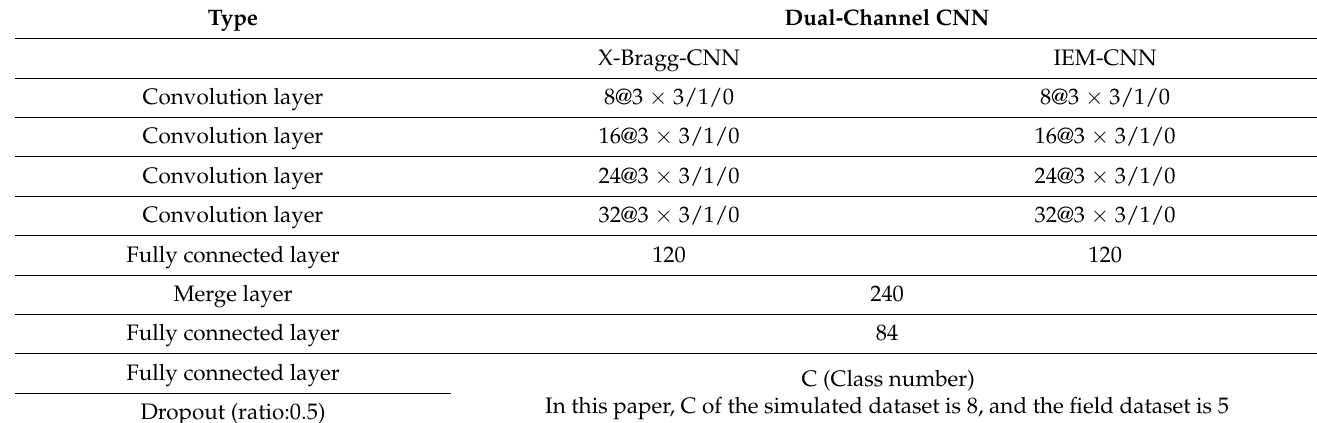
Table 3. Configuration of the regression